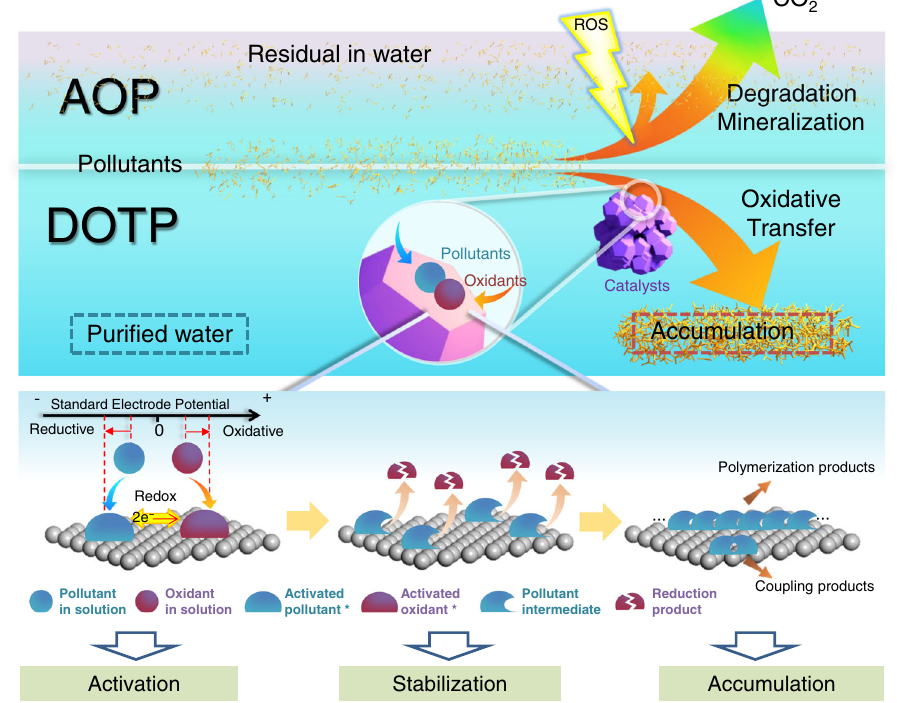
Fig. 6 Schematic illustration of DOTP and AOP. The surface (heterogeneous nanocatalysts) functions (i.e., activation, stabilization, and accumulation) of DOTP and the comparison with AOP for water puri fi